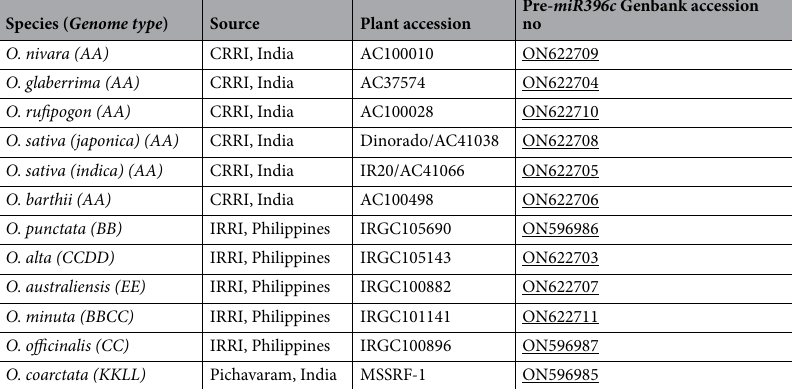
Table 1. List of Oryza species used for the current study and accession numbers of precursor miR396c sequences. Underlined text provides a clickable link to the corresponding DNA sequence at the NCBI database https:// www. ncbi. nlm. nih.